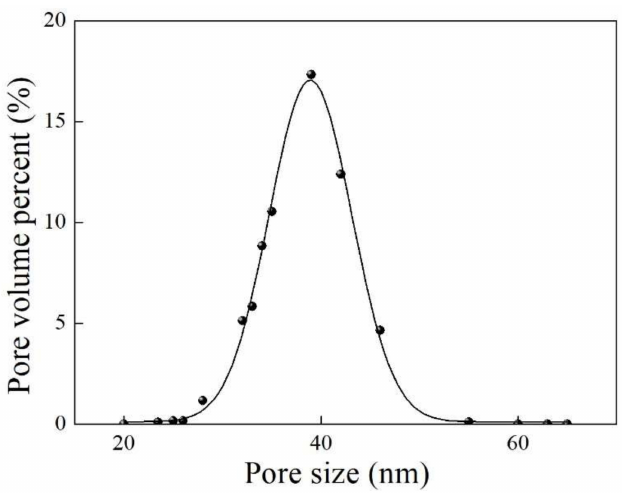
Figure 6. Pore size distribution of the mullite-CNT composite membrane.